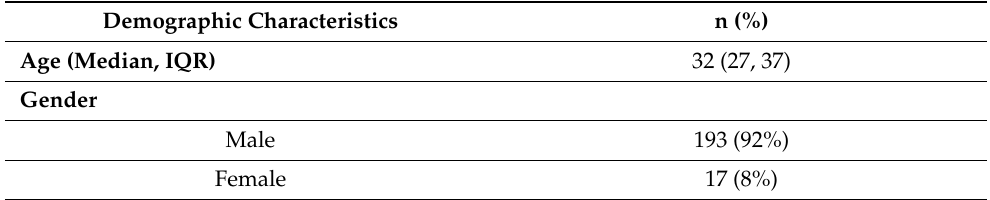
Table 1. Demographic details of study participants (n =